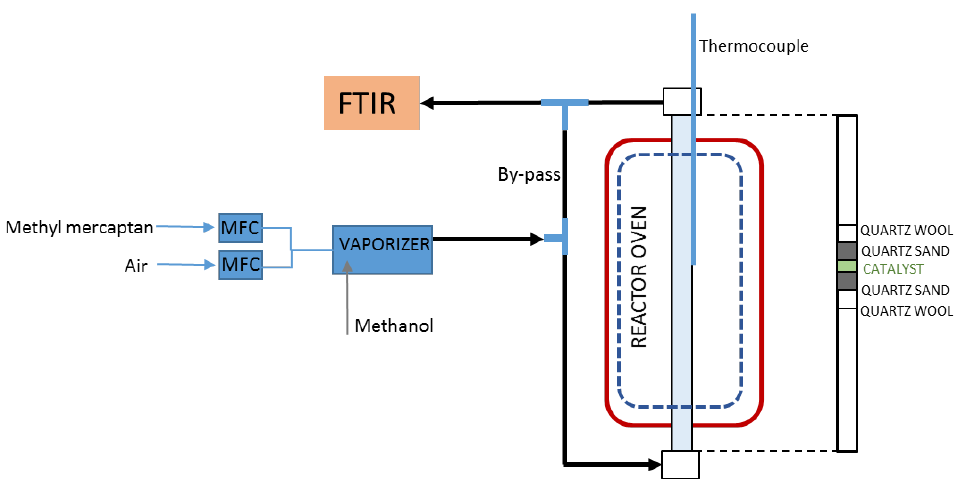
Figure 13. The experimental set-up for the catalyst activity testing.